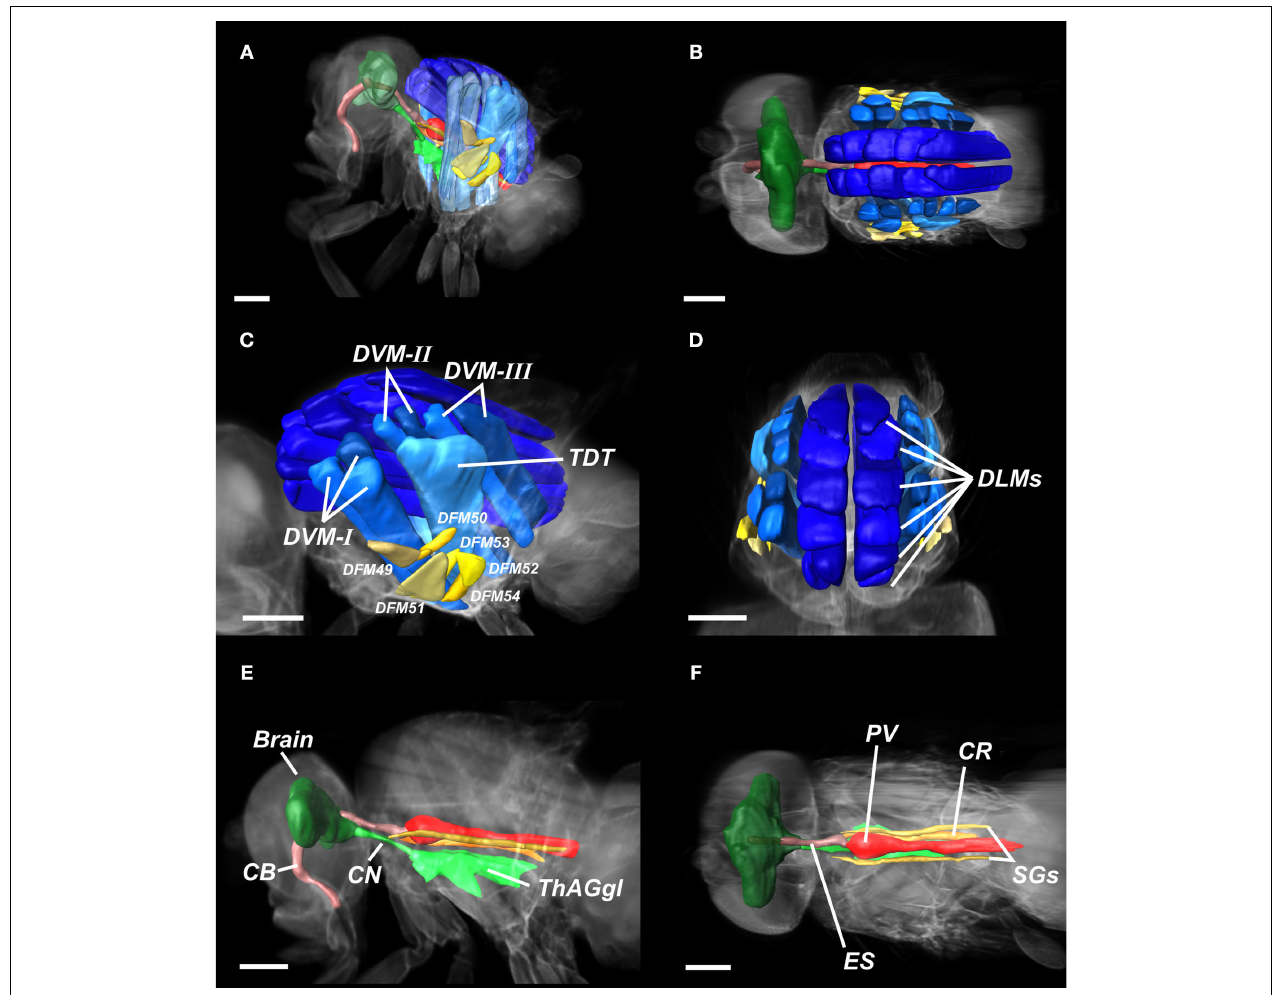
trochanter (light-blue). (E-F) Detail of the CNS and the intestinal system. Brain (dark green), CN, cervical connective (green); ThAGl, thoracico-abdominal ganglion, (light-green); CB, cibarium (light-rose); ES, oesophagus (rose); PV, proventriculus (red); SGs, pair of salivary glands (brown); CR, crop (orange). Length of scale bar 200